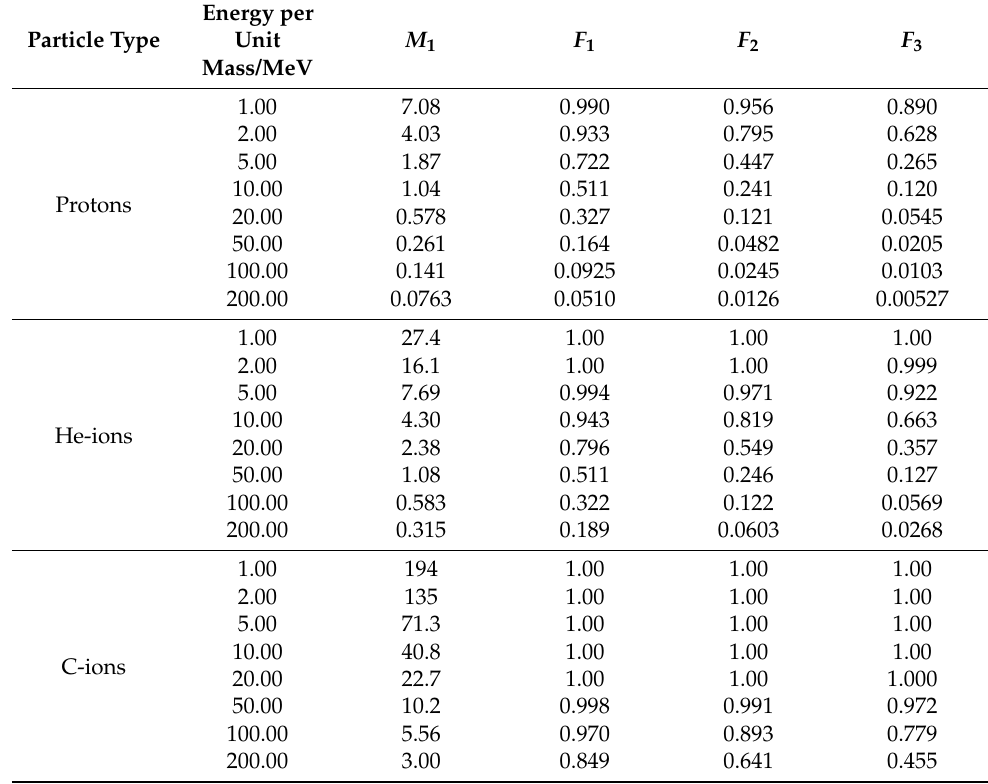
Table A4. Nanodosimetric quantities for protons, helium and carbon ions in a sphere of D = 10